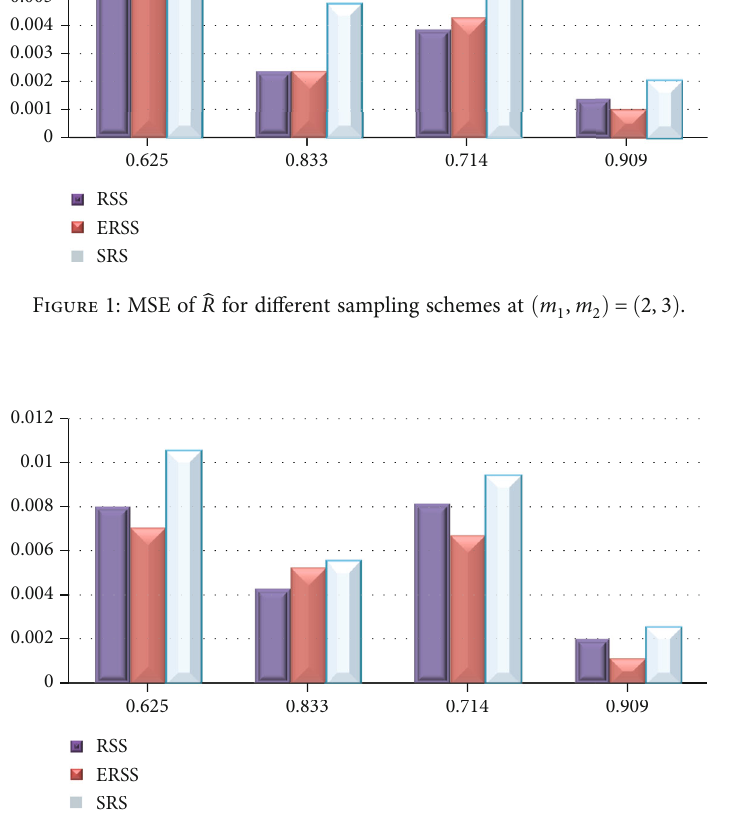
Figure 2: MSE of ̂ R for di ff erent sampling schemes at ð m